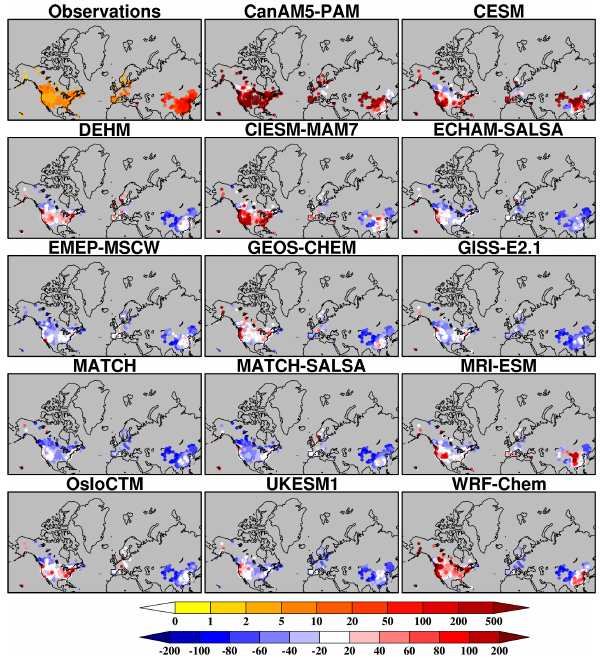
Figure 23. Measured ground-level PM 2 . 5 concentrations (µgm − 3 ) and model biases (as model–measurement / measurement in per- cent, bottom color bar) for 2014–2015. The upper color bar rep- resents observations, and the lower bar represents model